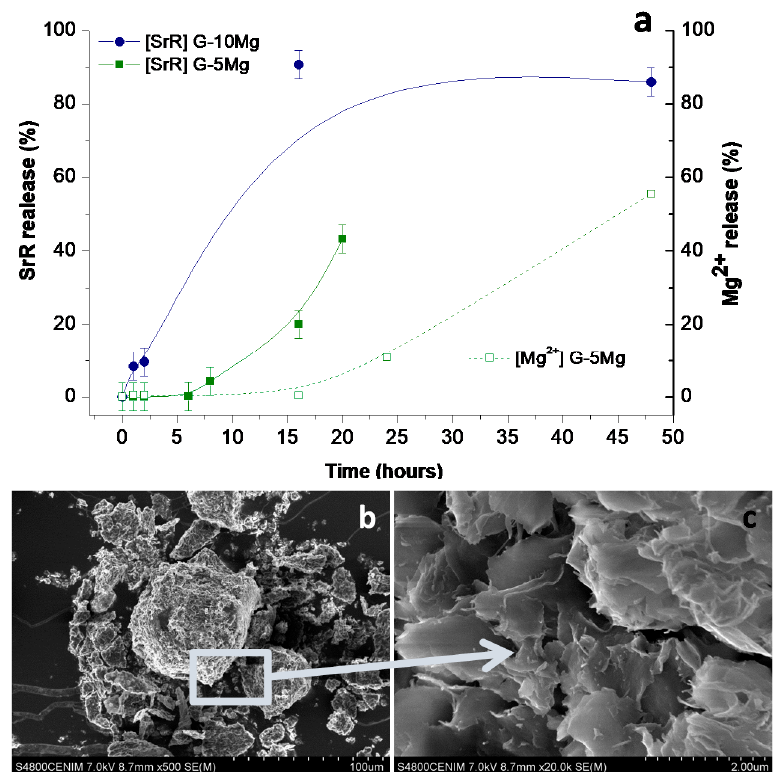
Figure 4. ( a ) Sr 2+ and Mg 2+ concentration determined by inductively coupled plasma (ICP) in the immersion medium during the degradation of G-5Mg and G-10Mg granules in phosphate buffer solution PBS and ( b ) Mg particle covered by polylactic acid (PLA) (c).